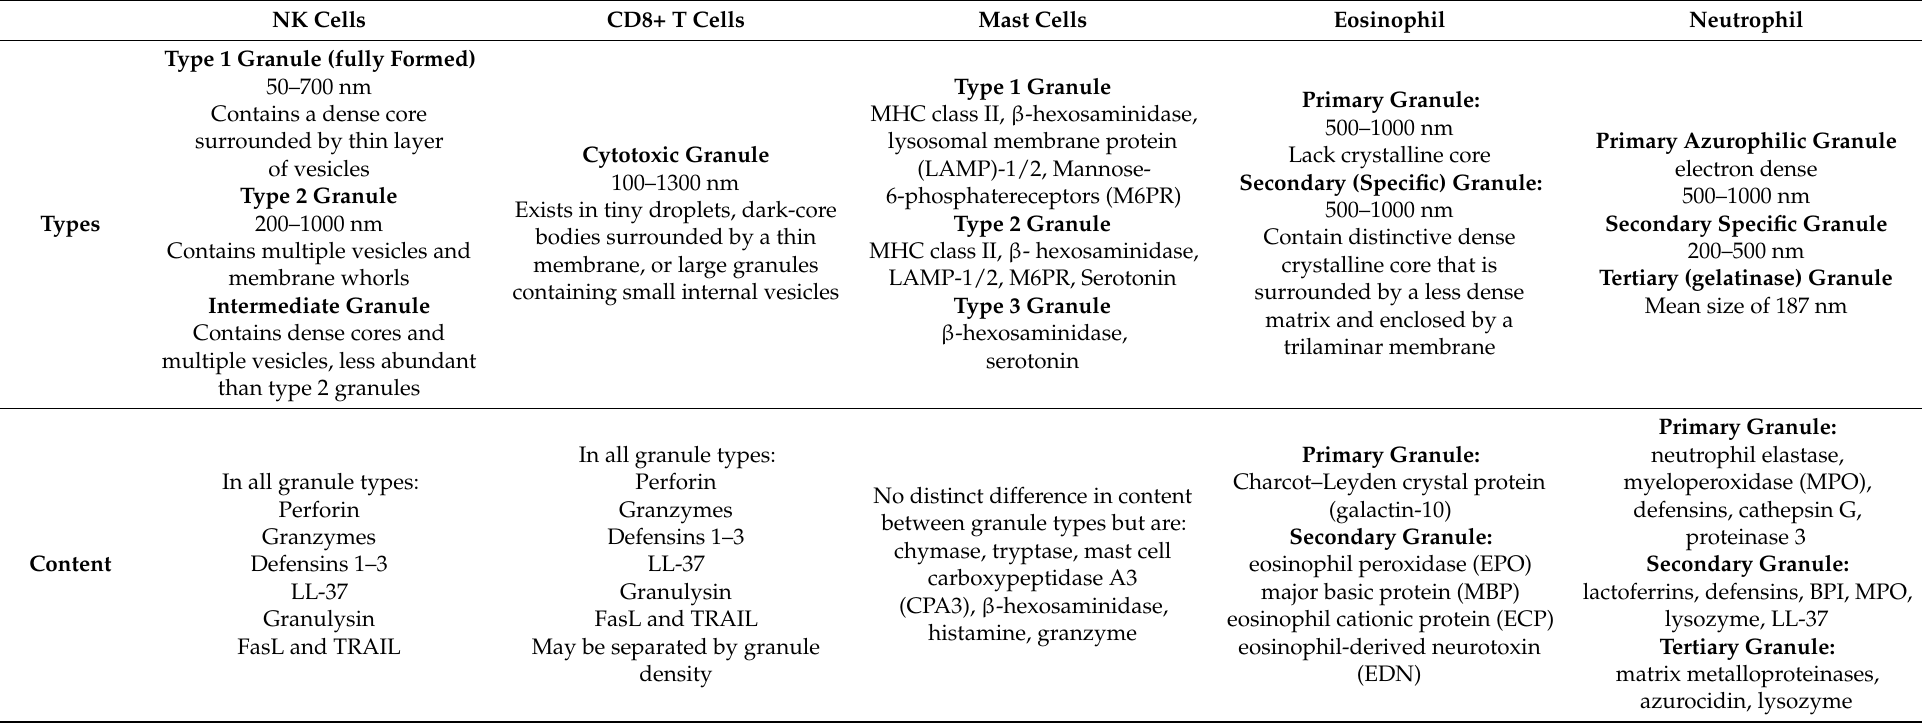
Table 1. Granule types and contents in various immune